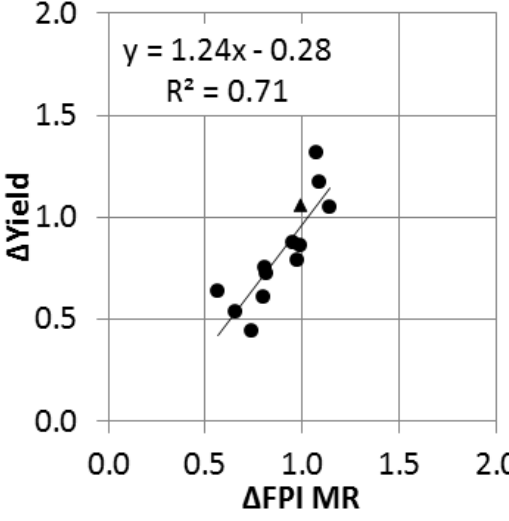
Figure 6. Scatterplot of the linear regression between ΔFPI MR and ΔYield measured at 13 resized ESUs of 1152 ha for the period 2012–2014 in the Lot and Aveyron departments. Circles represent ESUs with the triangle highlighting one ESU where the indices vary in opposite directions. ΔFPI MR and ΔYield are respectively given by Equations (4) and